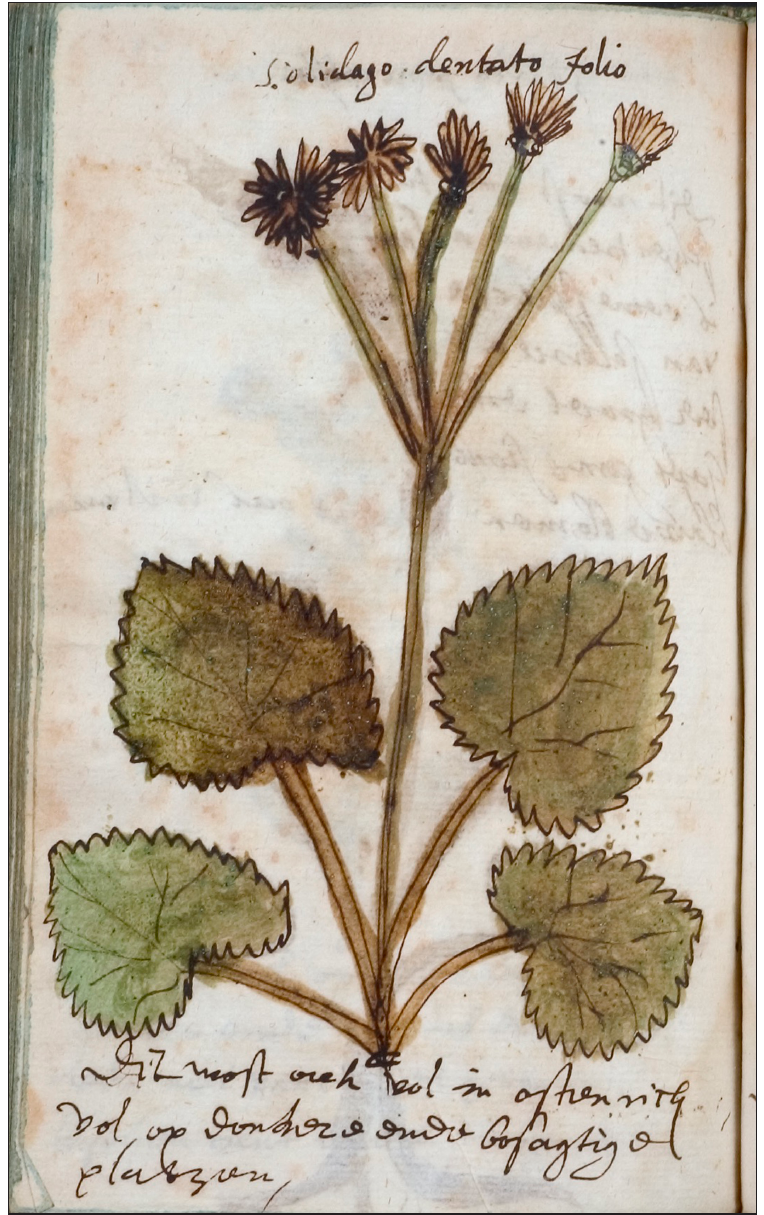
Figure 3: A page from Johannes van Heeck, De vegetalibus, ms. H. 507, 123v, BU historique de médecine, Bibliothèque interuniversitaire de Montpellier, Montpellier, FR (BIU Montpellier, Service